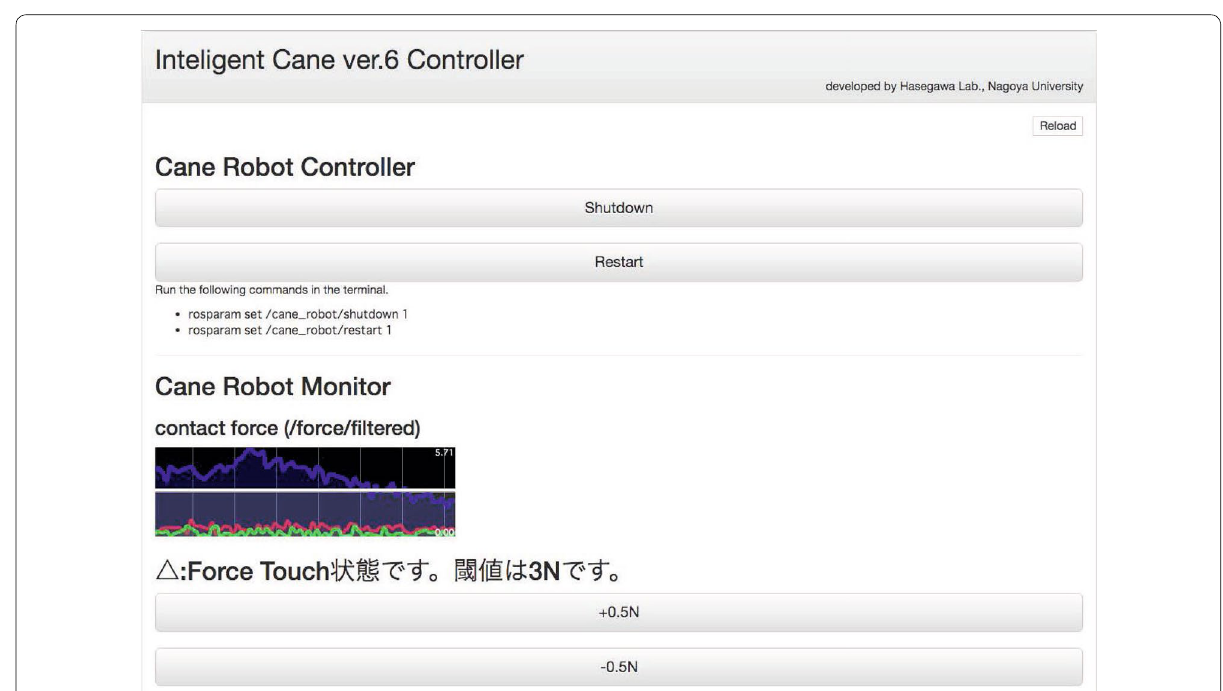
Fig. 3 Graphical user interface of the cane robot. The developed GUI allows the user and the instructor to operate and monitor the cane robot intuitively. In the current implementation, they can send several commands such as “start” and “stop” and check the interaction force applied to the handle in real-time